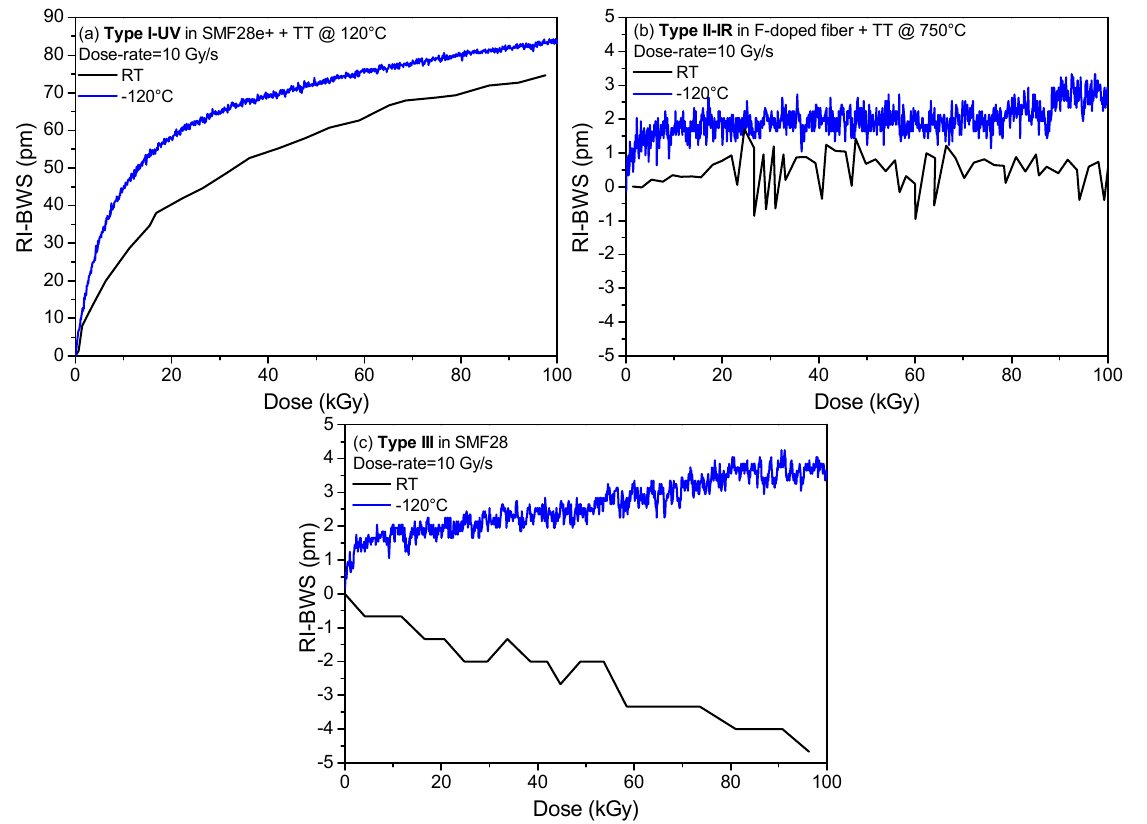
Figure 14. BWS induced by X-rays as a function of the dose at two different temperatures, for different FBG types: ( a ) a type I FBG written with a UV laser (at 244 nm) in an H 2 -loaded Ge-doped fiber (SMF28e) treated at 120 °C for 8 h, with a dose rate of about 1 Gy/s; ( b ) a type II FBG in an F- doped fiber with an fs-IR laser (at 800 nm, with a pulse width of 50 fs) treated at 750 °C for 15 min, with a dose rate of 10 Gy/s; ( c ) a type III in the same F-doped OF written PbP with an fs-IR laser (centered at 800 nm, with a pulse width 120 fs), with a dose rate of 10 Gy/s. Data extracted from [100].